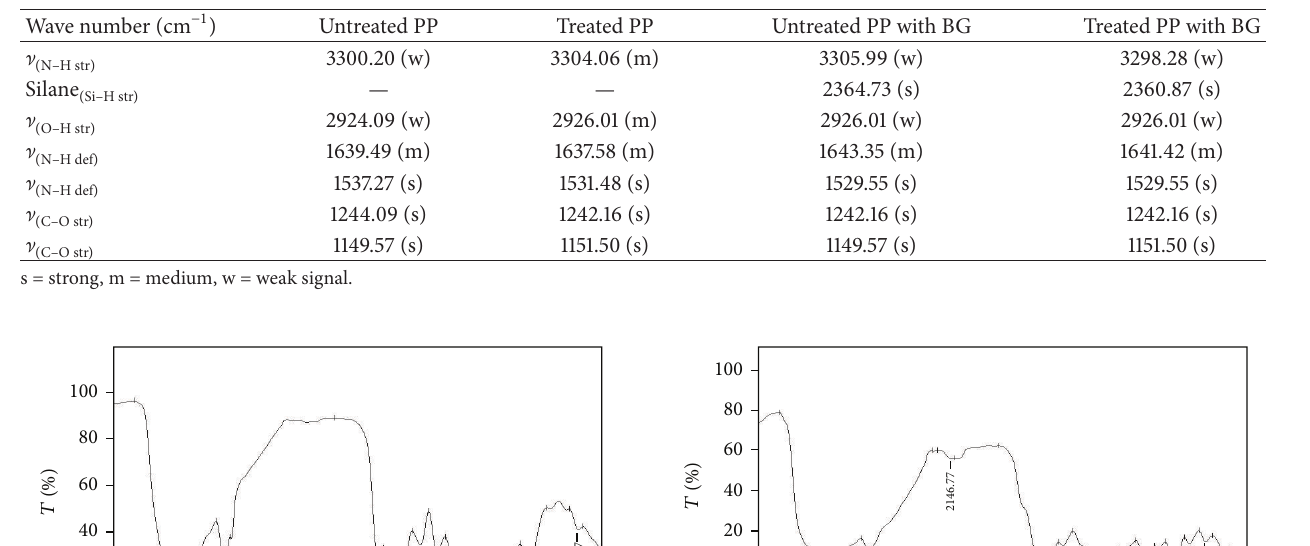
Table 5: Characteristic FT-IR adsorption frequencies of functional groups of PP.